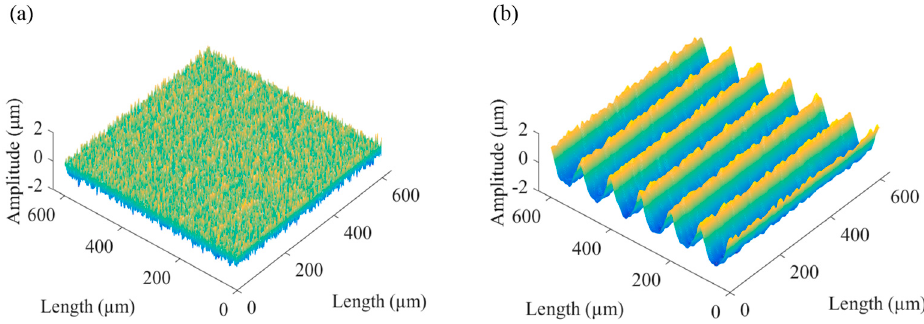
Figure 9. Reconstructed surfaces: ( a ) reconstructed rough surface; ( b ) reference plane.